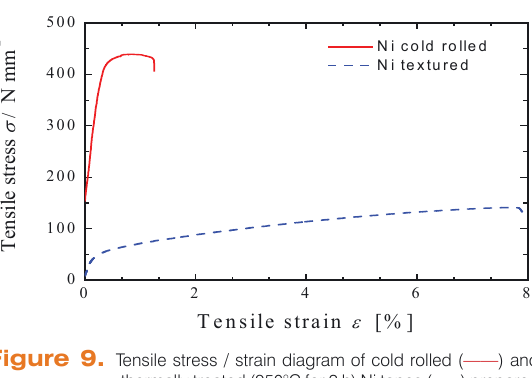
Figure 6. Distribution of the grain diameter as a function of the area fraction.